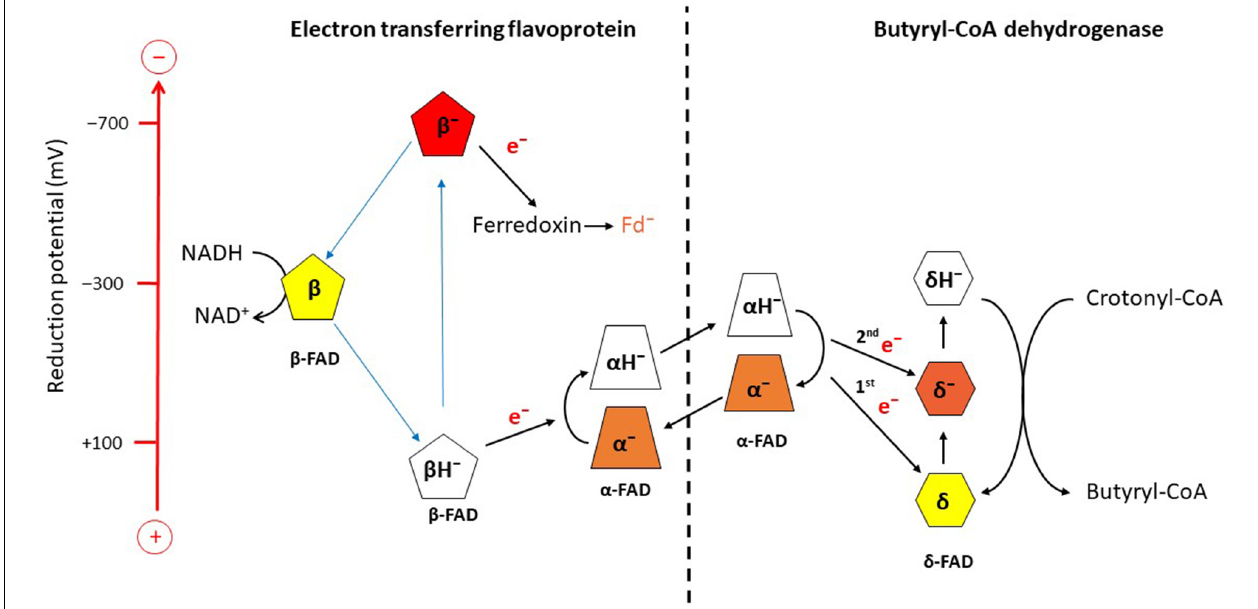
FIGURE 3 | Scheme of electron bifurcation in the EtfAB-Bcd complex. The different FADs are placed according to their approximate reduction potential. NADH reduces β -FAD to β -FADH − , which bifurcates. One electron goes to α -FAD − and the formed semiquinone, β -FAD •− , reduces ferredoxin (Fd) to Fd − . The formed hydroquinone ( α -FADH − ) swings over to Bcd and transfers one electron to δ -FAD. Note the decrase of the reduction potential of α -FAD •− due to the change in location from Etf to Bcd. Repetition of this process yields δ -FADH − , which reduces crotonyl-CoA to butyryl-CoA. The FAD semiquinones are red, the quinones yellow and the hydroquinones colorless (Sucharitakul et al.,